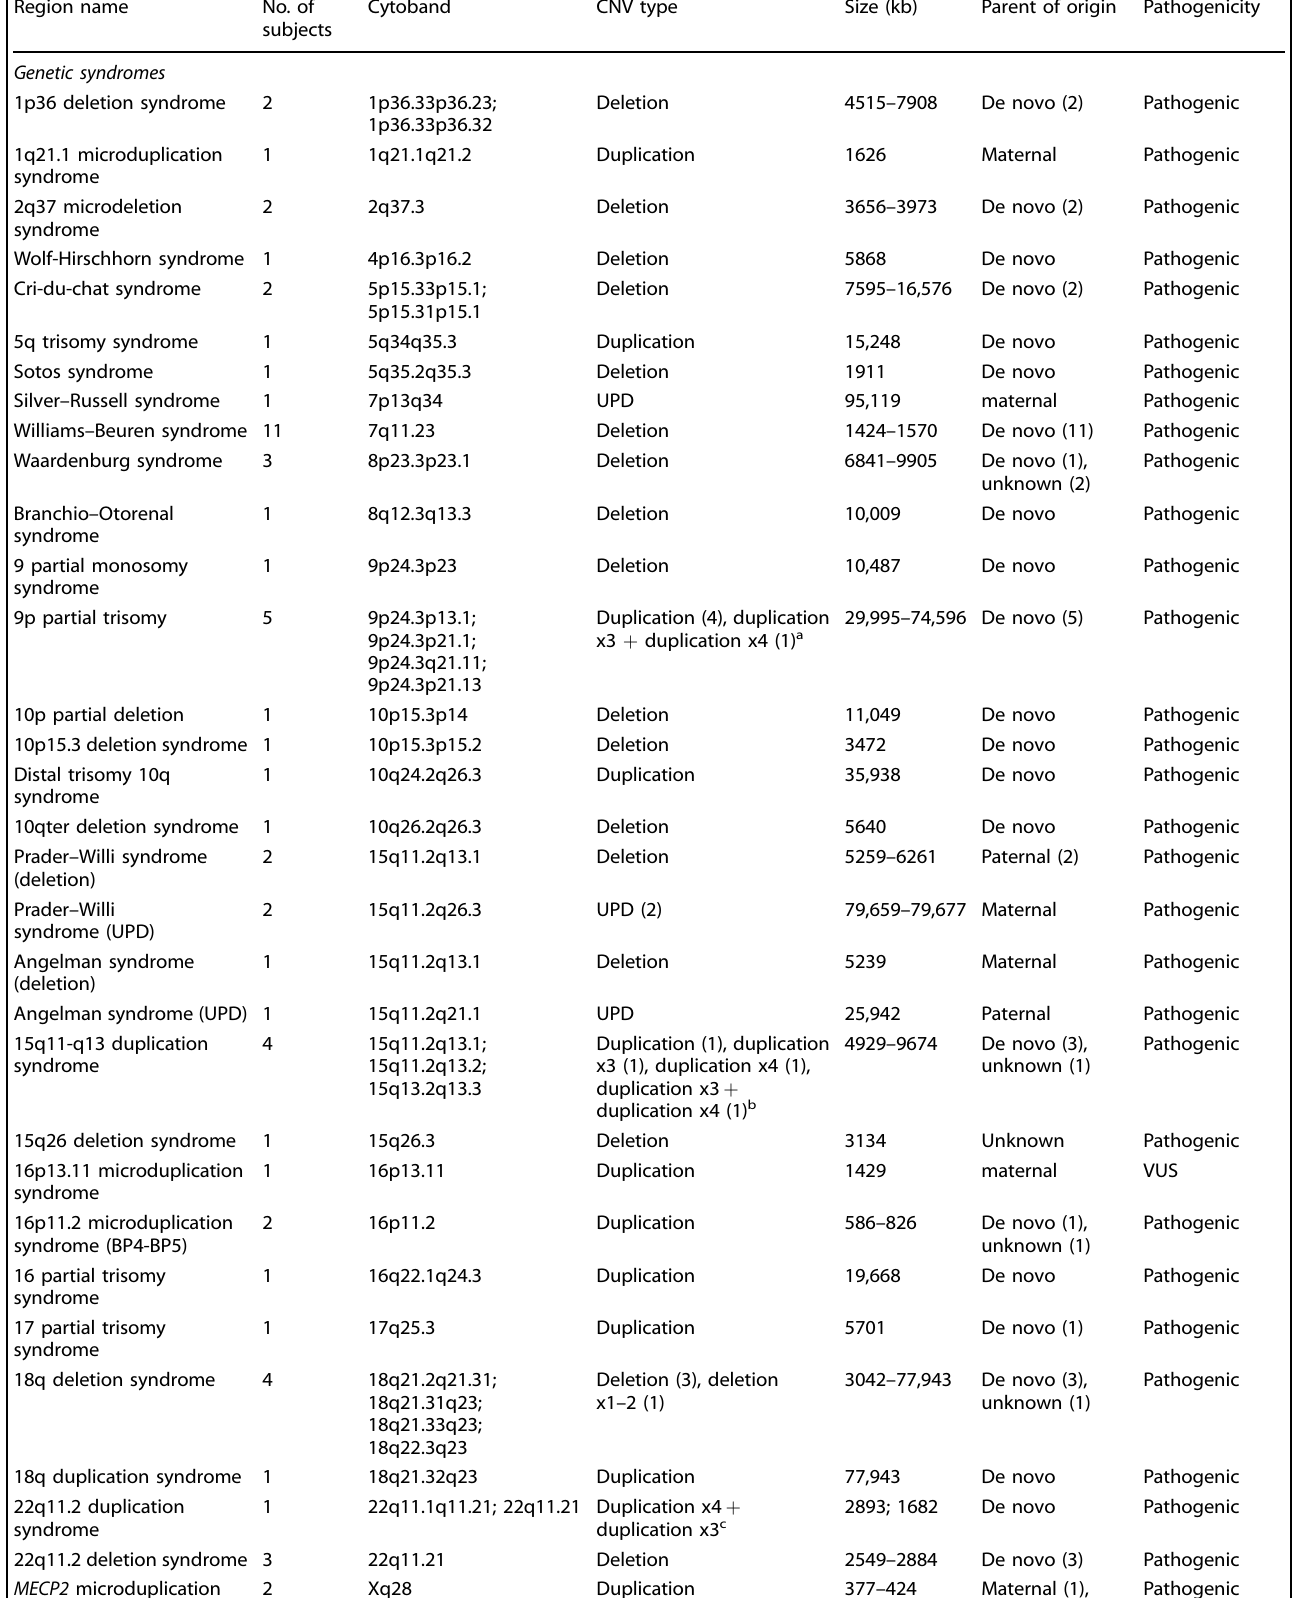
Table 3. Clinically relevant CNVs found in the patients with intellectual disability and developmental